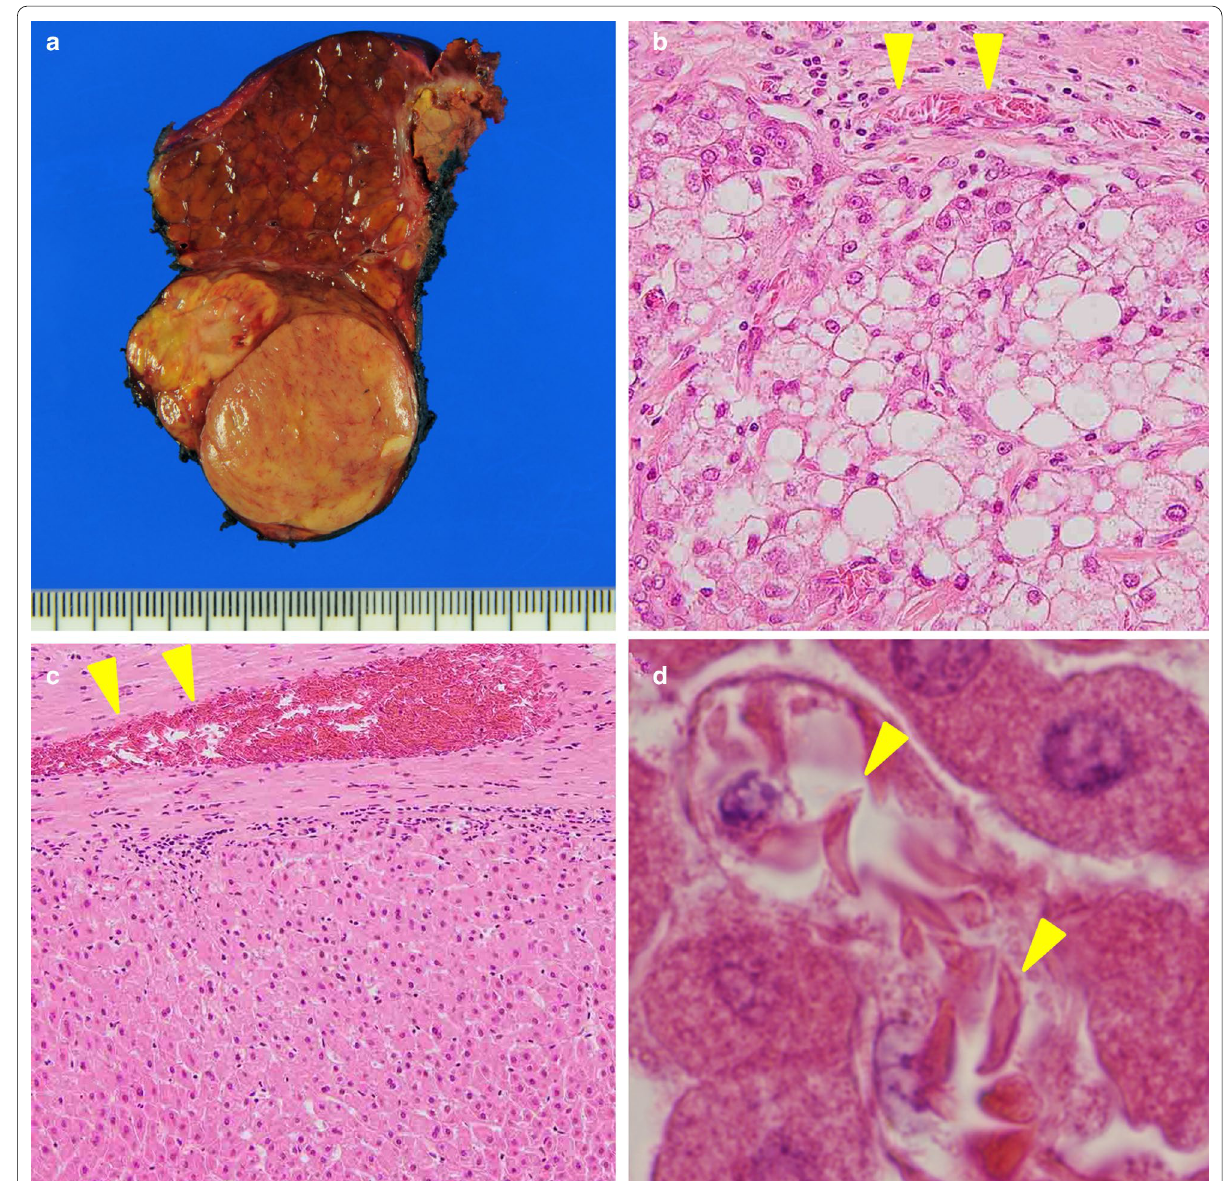
Fig. 5 Cut surface of the resected specimen showed a single nodular hepatocellular carcinoma, 3.9 cm in size ( a ). Intrahepatic peripheral blood vessels were filled with sickled erythrocytes in both tumor ( b ) and non-tumor areas ( c ). Sickled erythrocytes were observed in the sinusoidal